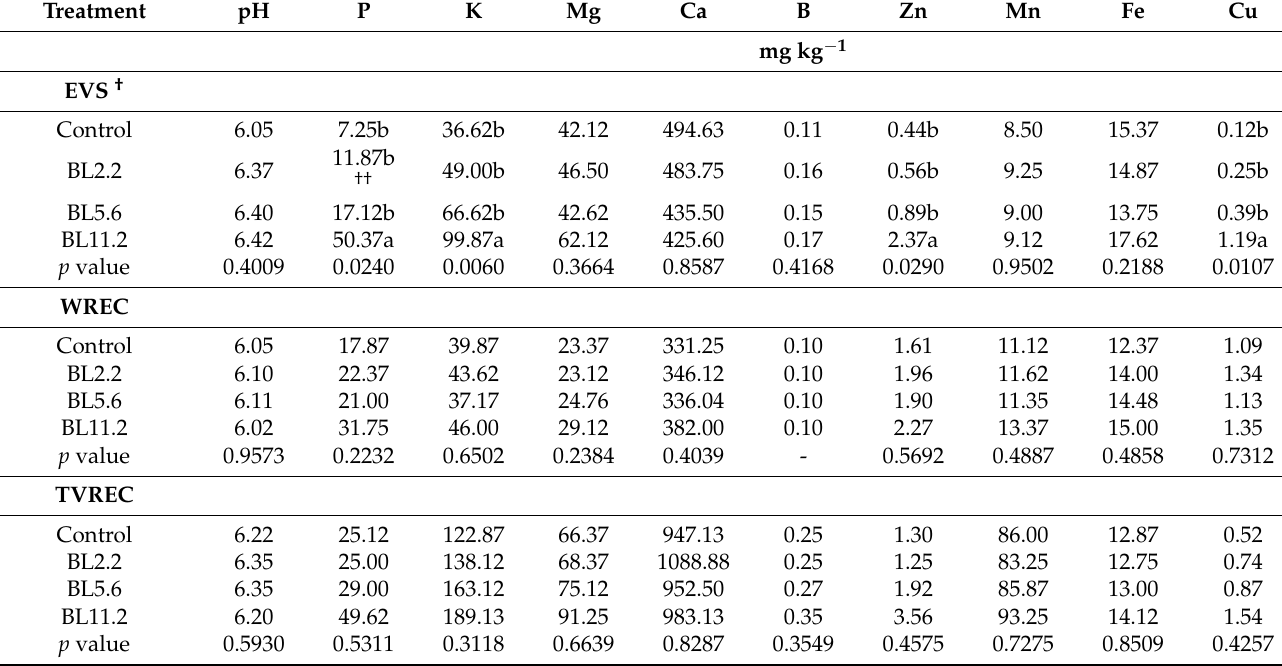
Table 6. Soil pH, and Mehlich-1 extractable nutrients of soil samples (0–0.15 m depth) taken at the end of the study at the experimental sites.